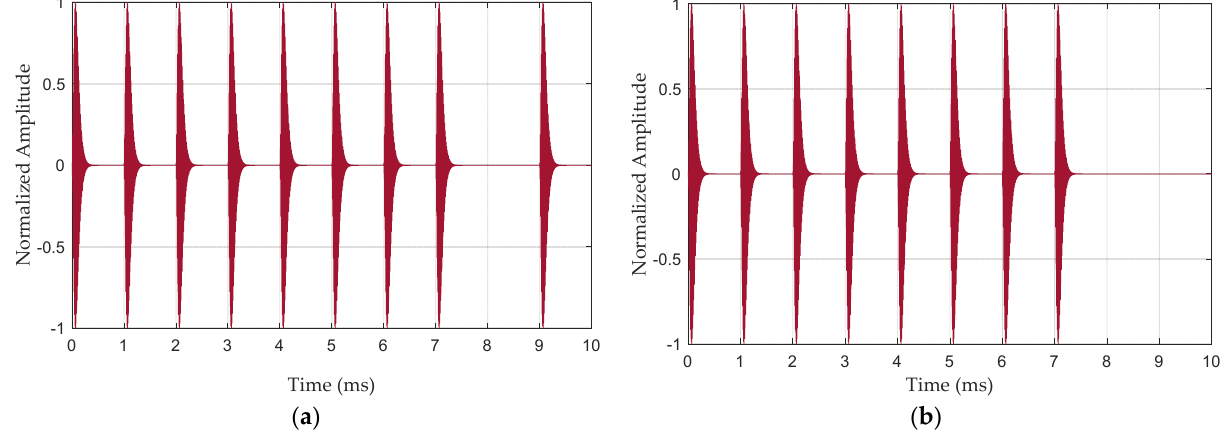
Figure 2. Characteristics of an eLoran pulse group signal: ( a ) pulse-group signal of master station; ( b ) pulse-group signal of secondary